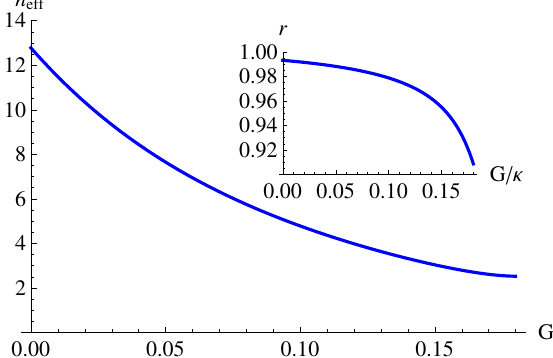
Figure 4. Plot of the effective mean vibrational number n ef f in the movable mirror as a function of the parametric gain G normalized to κ . Inset: the parameter r against the parametric gain G normalized to κ . Parameters: ℘ = 0.1 mW, θ =